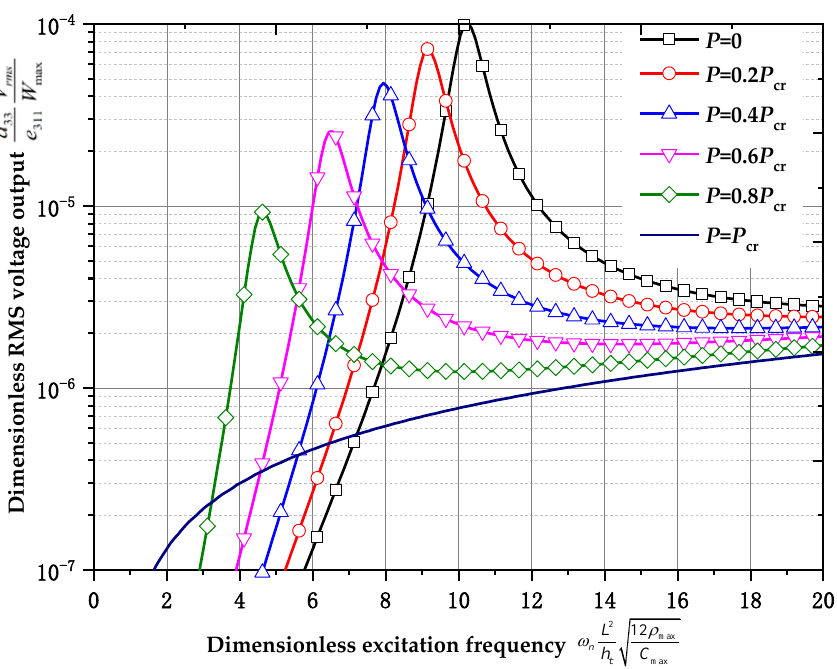
Figure 8. Dimensionless root mean square voltage output-excitation frequency curves for different